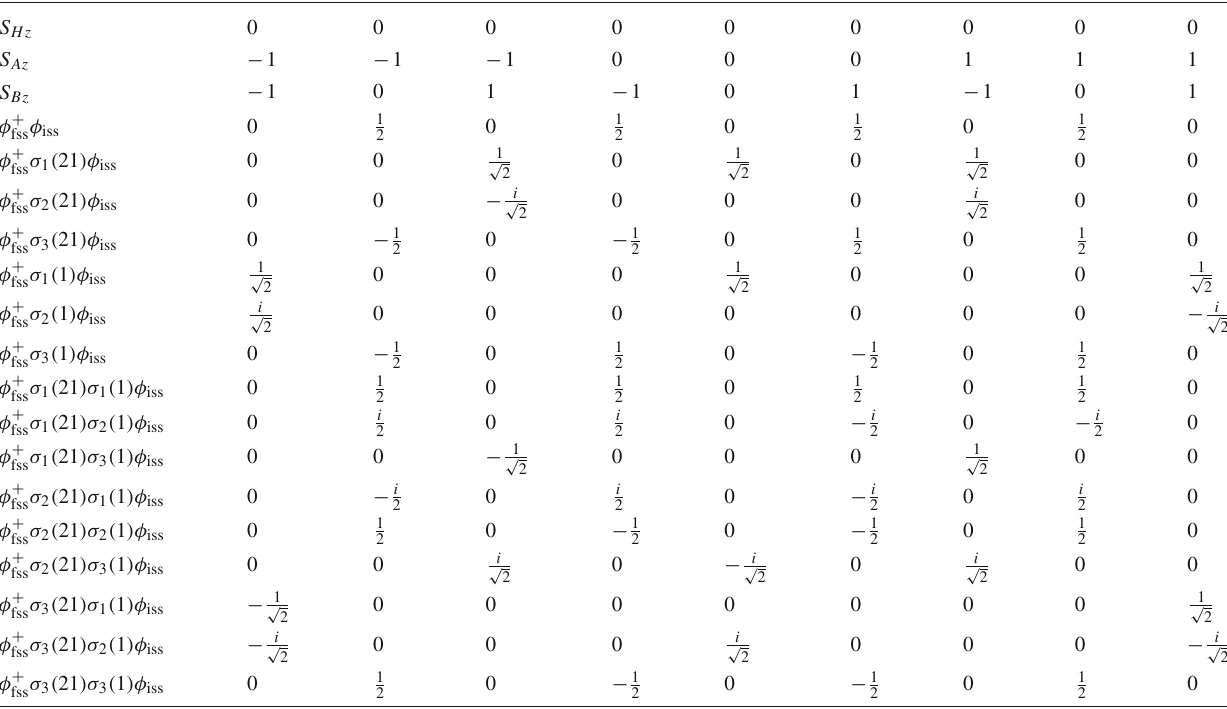
for A ( S A = 1 ) + B ( S B = 1 ) → H ( S H = 1 ) with S Hz = 1 ¯ q 2 ¯ q 1